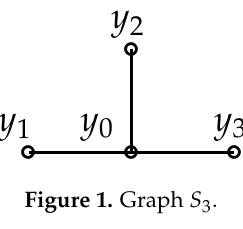
Figure 1. Graph S 3 .